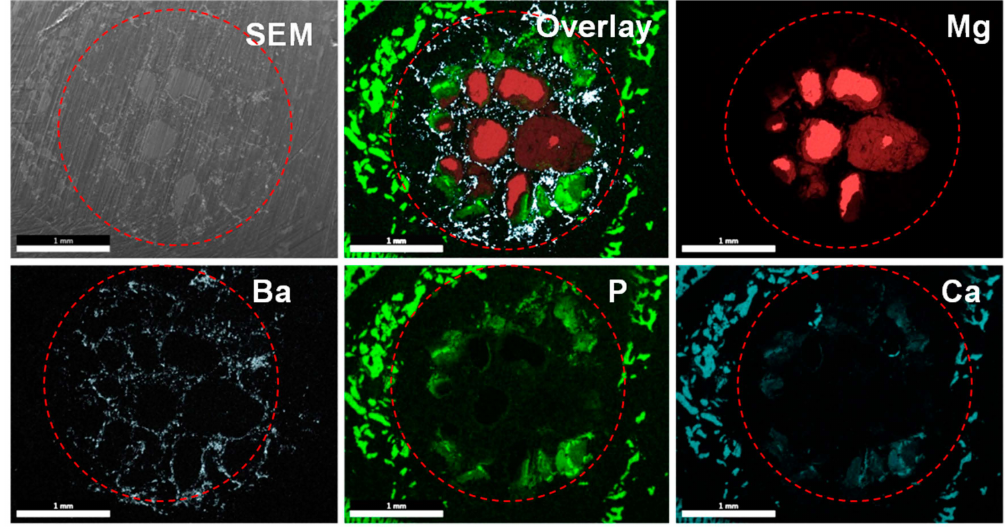
Figure 10. SEM and element mapping of Mg, Ba, P, and Ca of PMMA–41Mg and after implantation in rats for eight weeks. The red circles show roughly the boundary of bone cement. Scale bars, 1